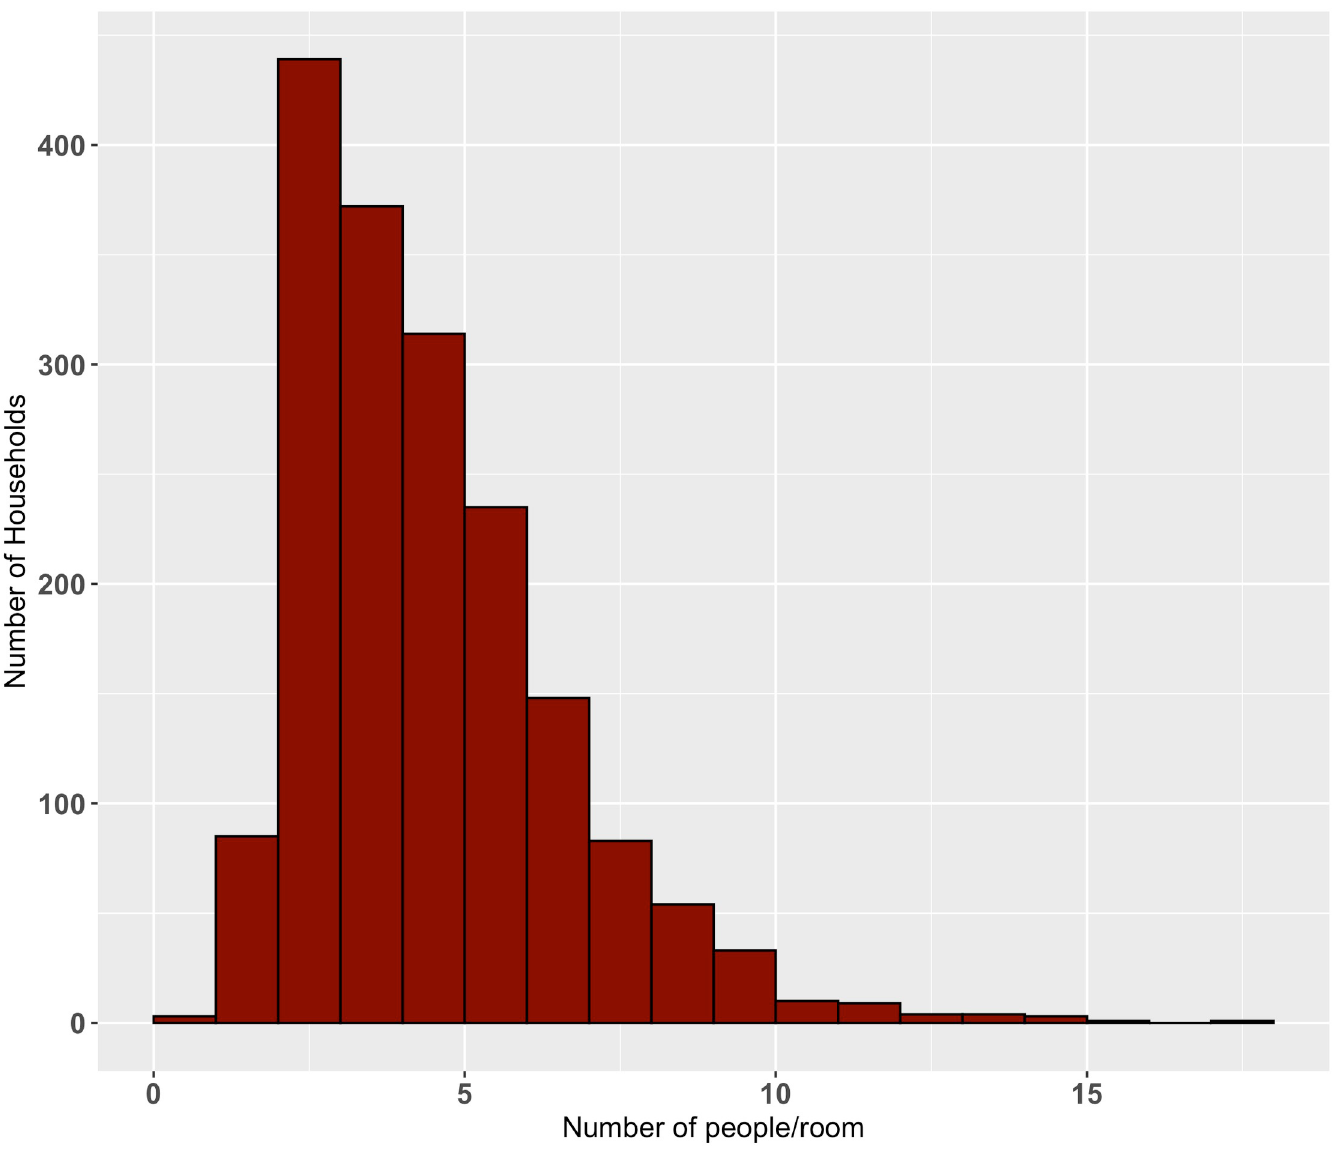
Fig 3. Distribution of the average number of people sleeping in each room at night (including both children and adults, calculated by the number of people sleeping in the house at night divided by the number of sleeping rooms in the